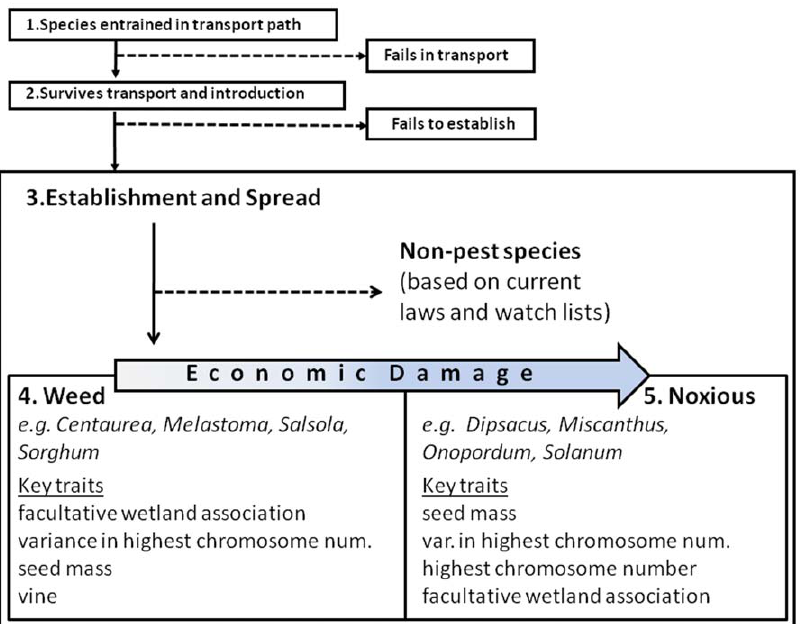
Figure 3. Schematic of the invasion process based on Kolar and Lodge (2001), but emphasizing the divergence in traits corresponding to the two classes of plants, weeds and noxious species.